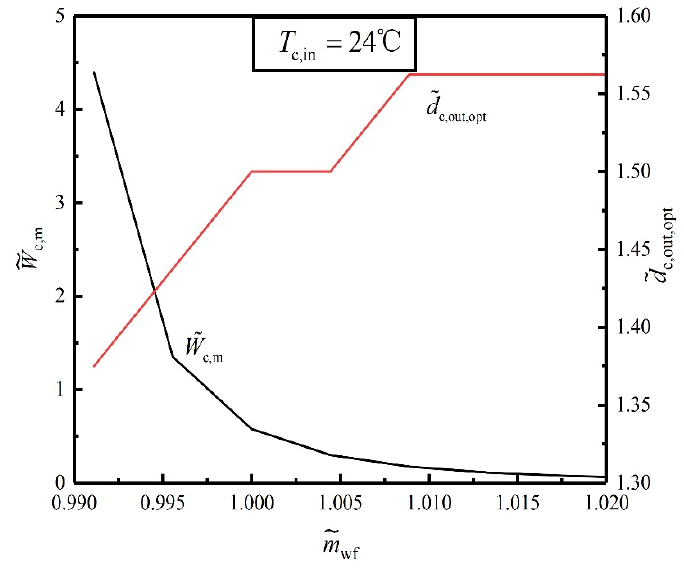
Figure 5. Influences of (cid:101) m wf on the (cid:101) W c , m and (cid:101) d c , out , opt .